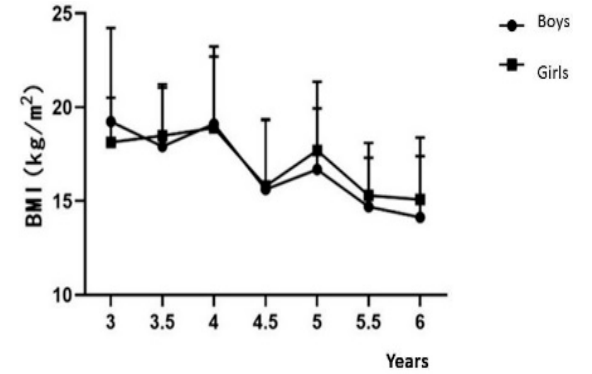
Figure 2. BMI of children aged 3~6.